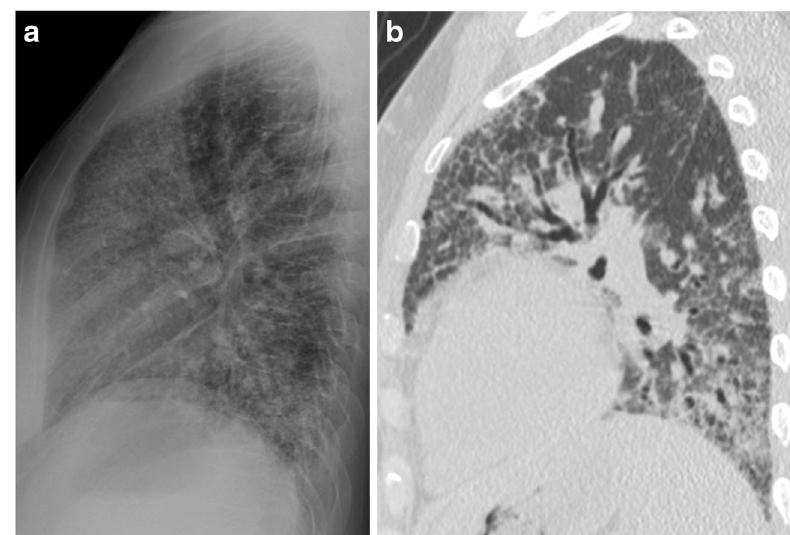
Fig. 3 53-year-old woman with chronic hypersensitivity pneumonitis. The lateral chest radiograph (a) projects fibrosis as well through the retrosternal clear space as at the lung bases. A corresponding sagittal CT slice (b) is